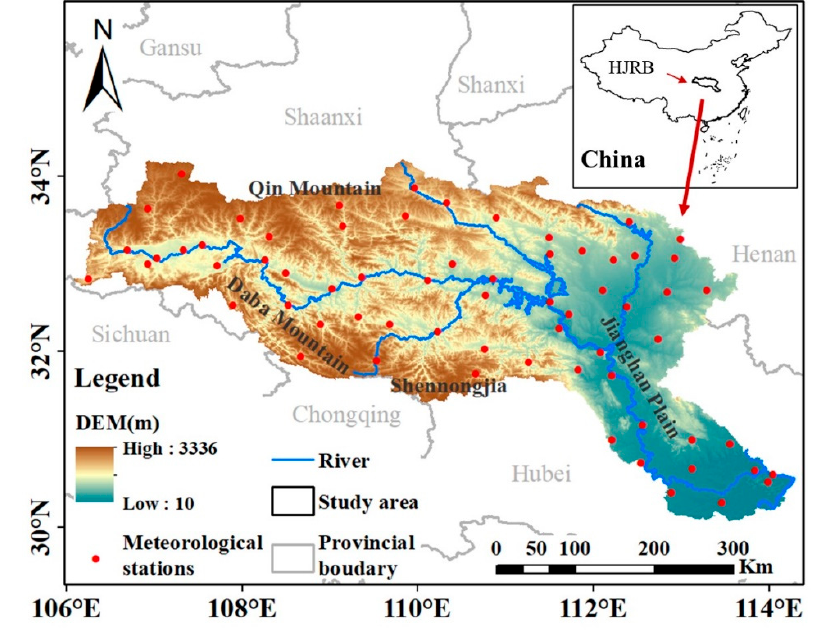
Figure 1. The study area.